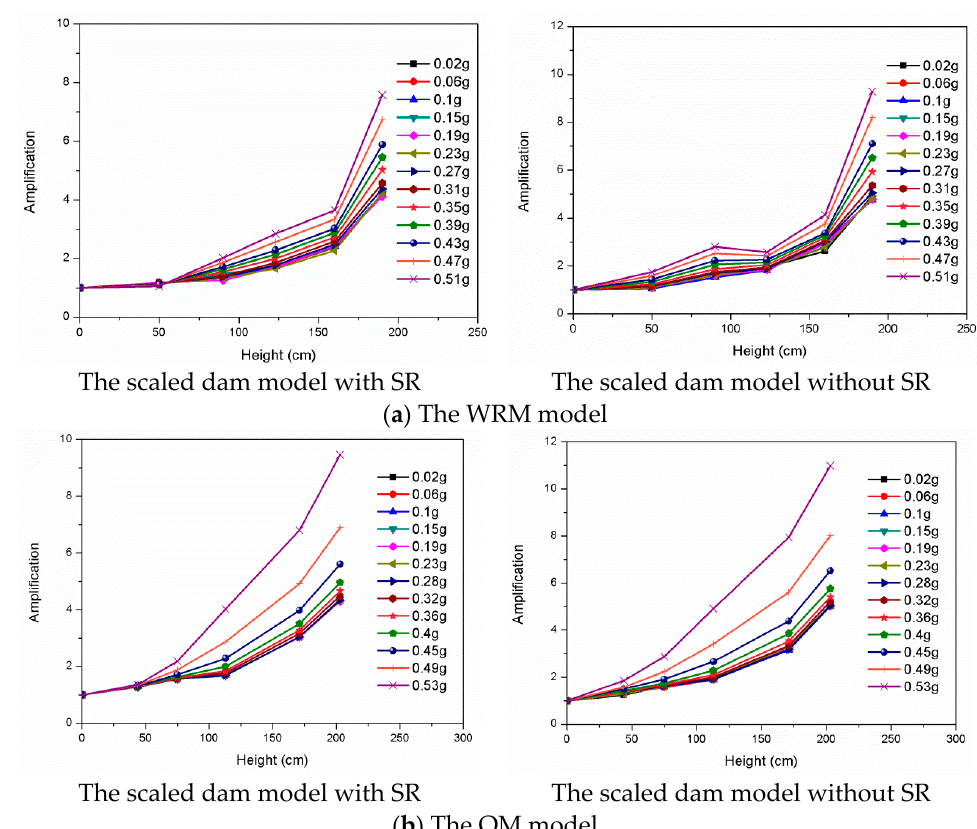
Figure 5. The variation of acceleration amplification factor with height.